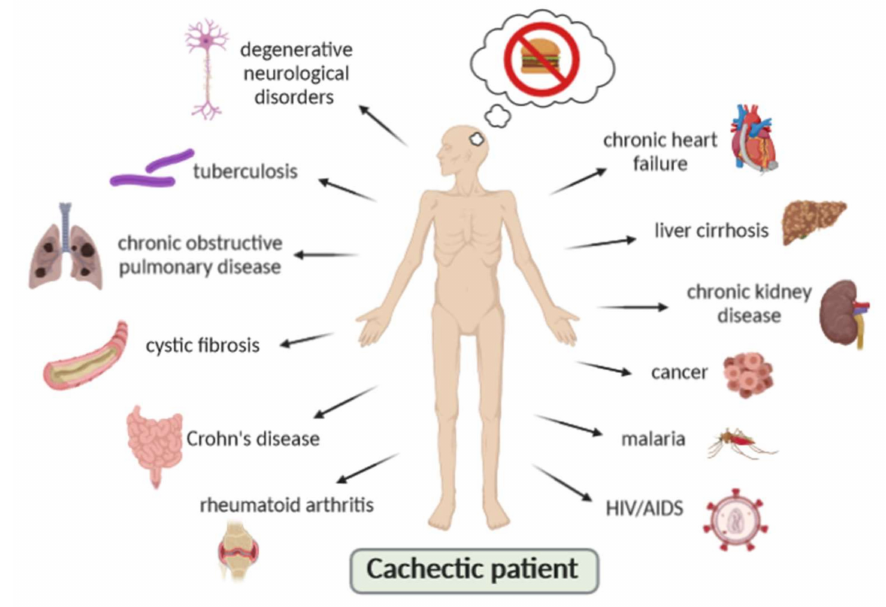
Figure 2. Cachectic patient in association with chronic